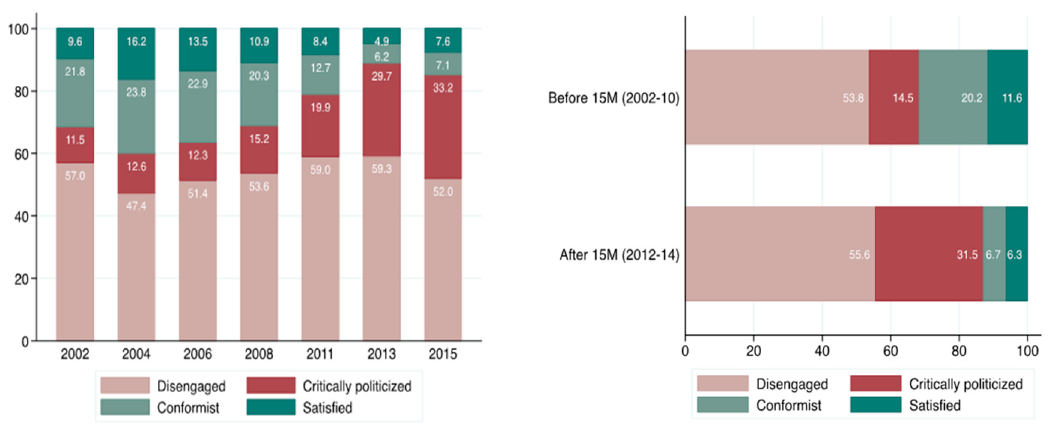
Figure 6. Evolution of the typology of attitudes towards politics in Spain, 2002–2015. Source: European Social Survey in Spain, rounds 1–7.